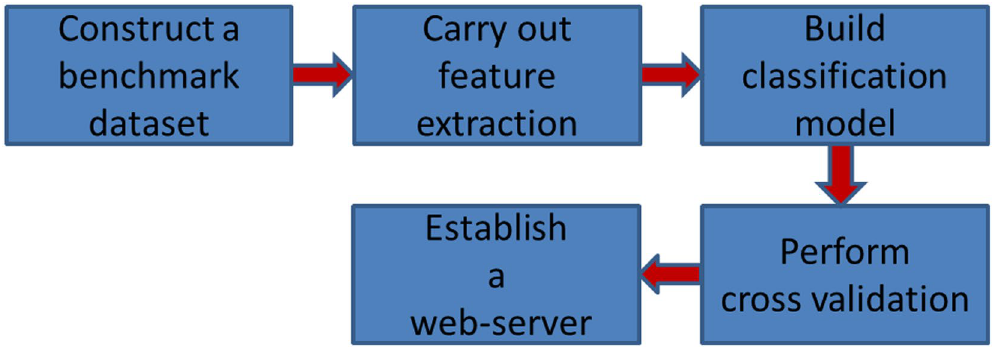
Figure 2. Sketch map showing the steps how to establish a predictor for biological